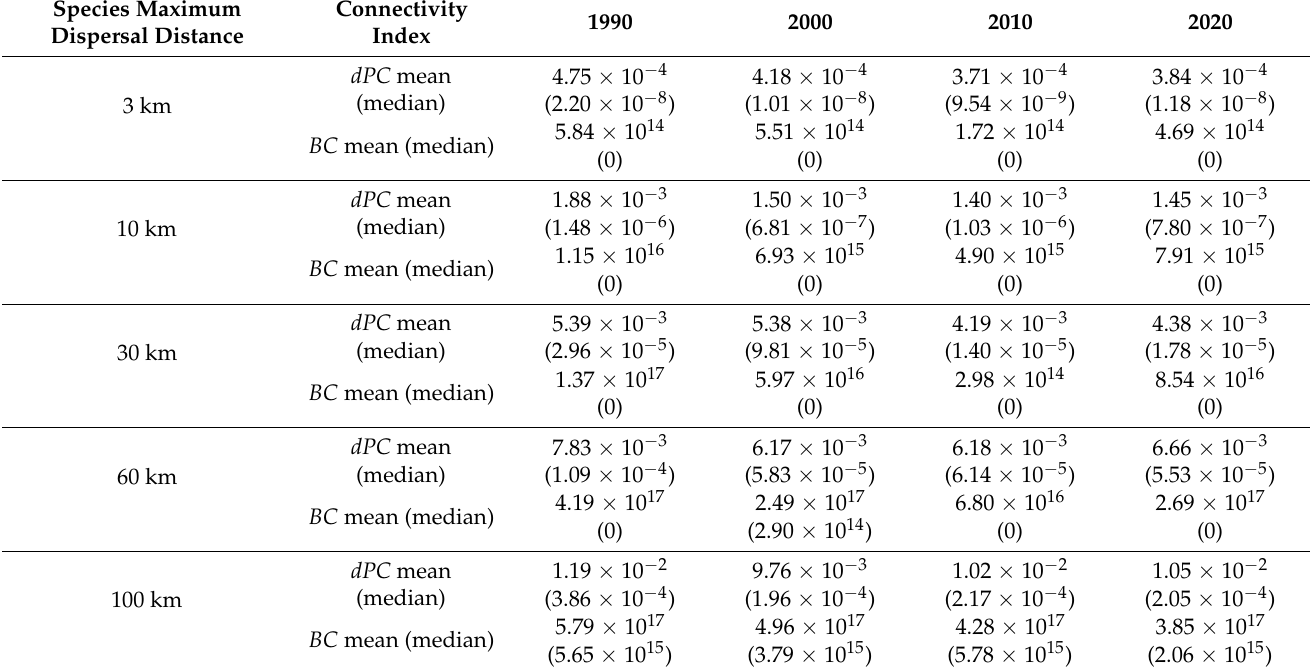
Table 4. Changes in ecological source connectivity indicators from 1990 to